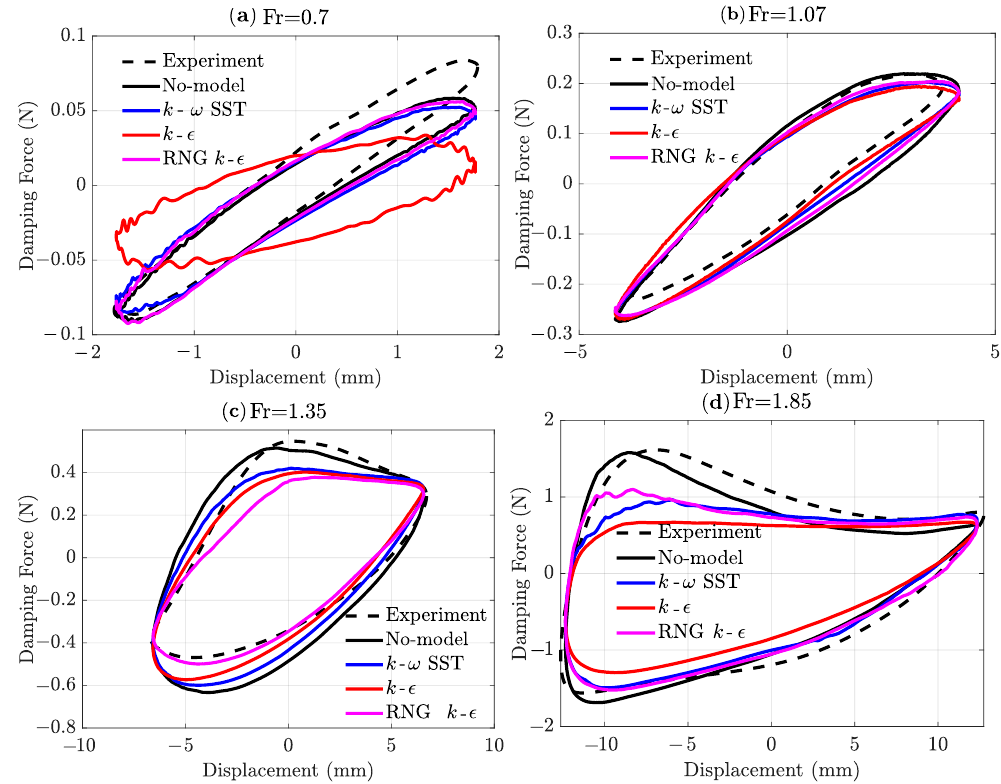
Figure 7. Phase average of the damping forces for different Fr numbers. ( a ) Fr = 0.7, ( b ) Fr = 1.07, ( c ) Fr = 1.35, ( d ) Fr =